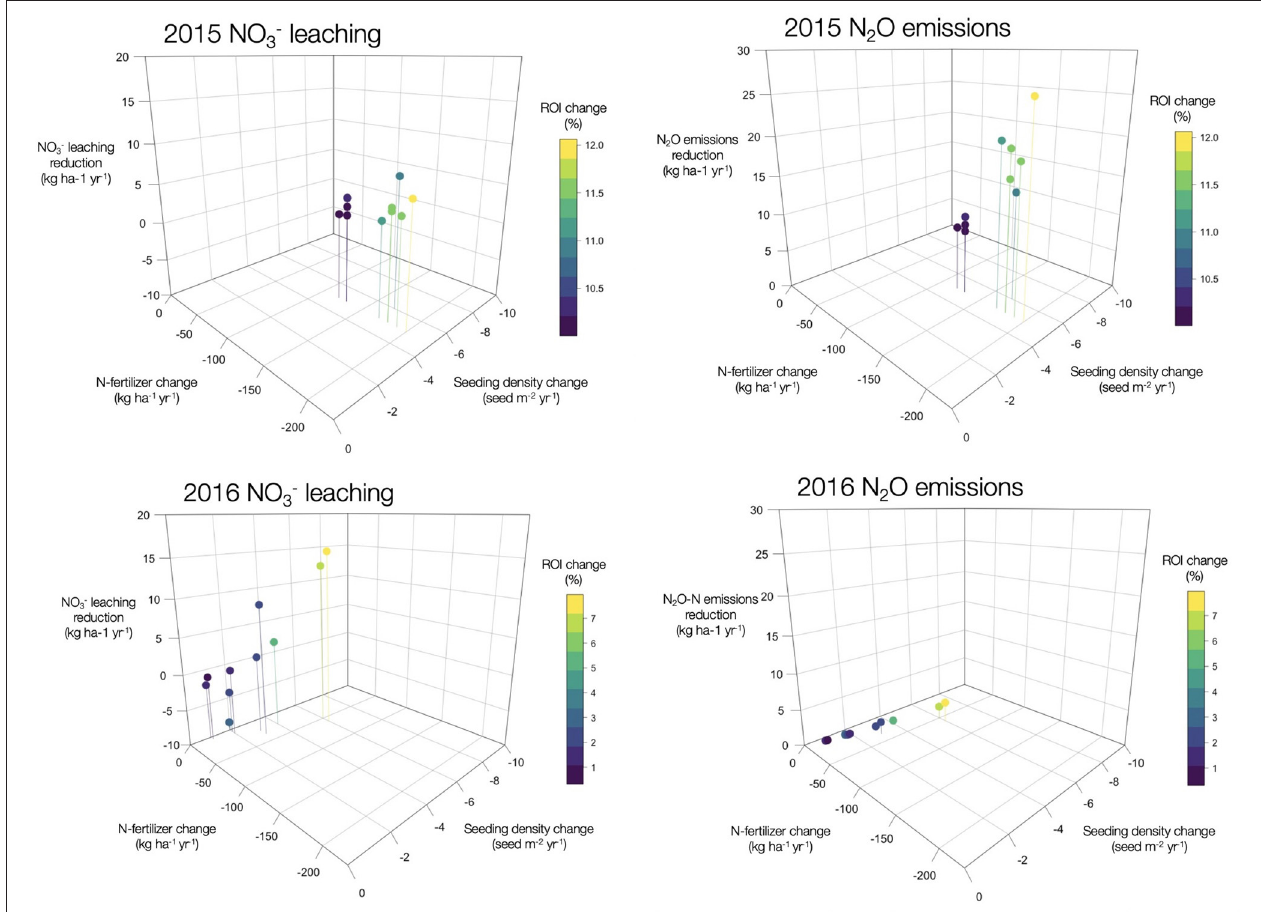
FIGURE 11 | NO 3 − leaching and N 2 O emission changes associated with a shift from managing for maximum yield (agronomic optimum inputs) to managing for maximum ROI (economic optimum inputs). Data points represent changes corresponding with each subfield soil type during 2015 and 2016 ( Table S7